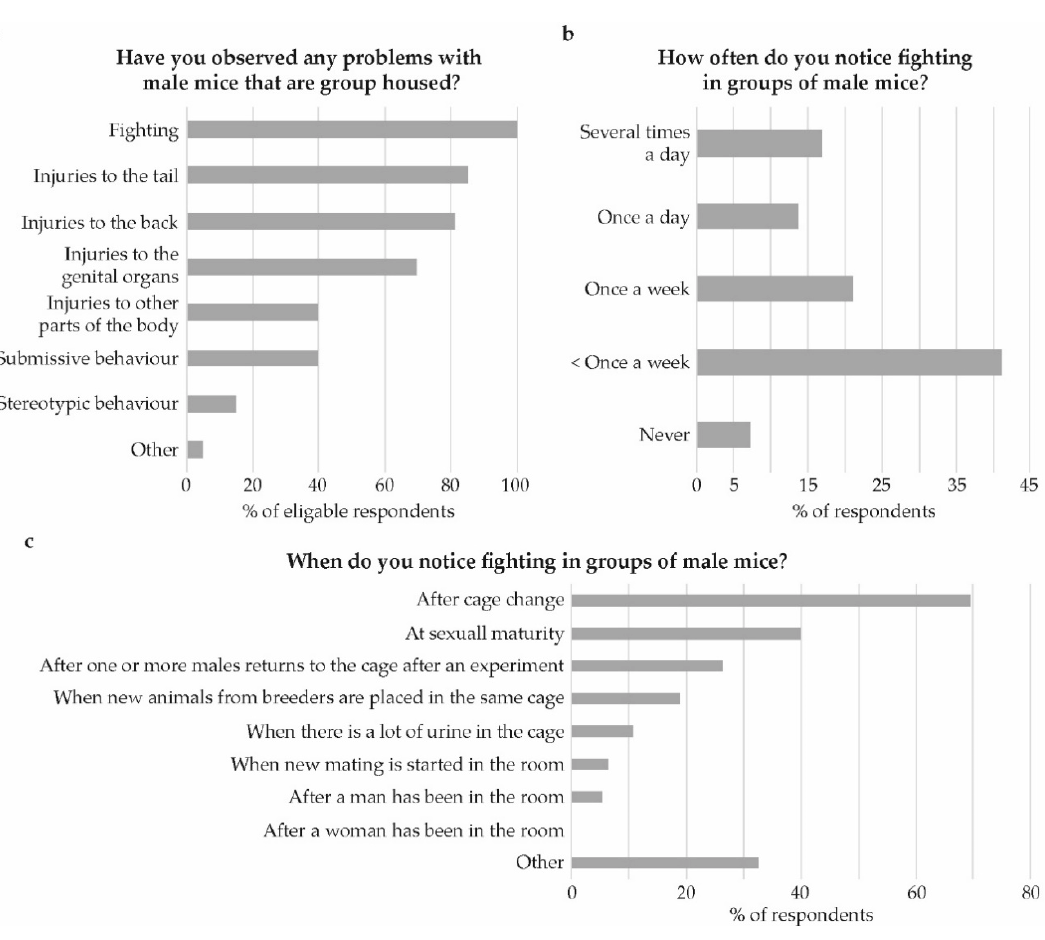
Figure 5. Observation of aggression among group housed male mice. ( a ) Have you observed any problems with male mice that are group housed? ( b ) How often do you notice fighting within male groups? And, ( c ) When do you notice fighting in groups of male mice?